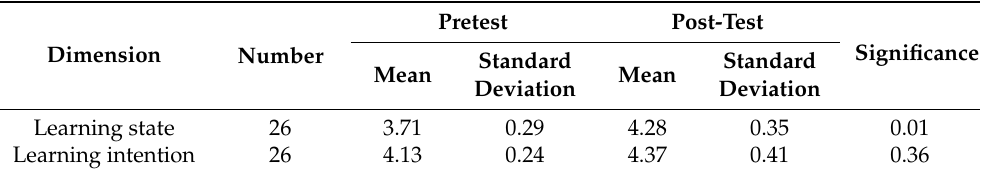
Table 13. Pretest and post-test t -test analyses of Experimental group B programming attitude ques-